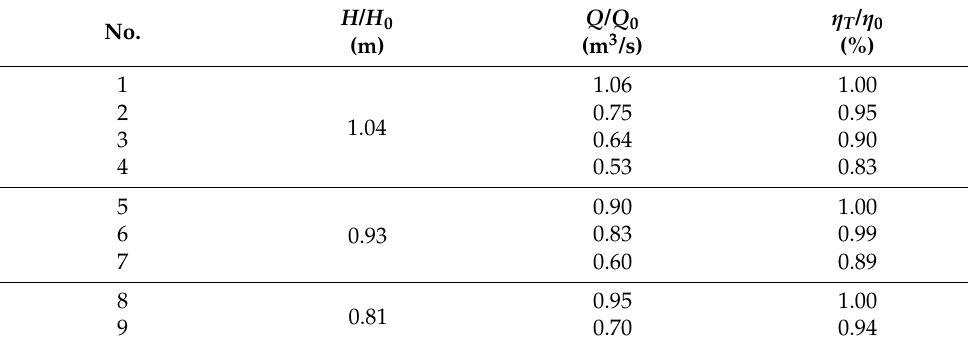
Table 1. The turbine operation parameters without aeration system used in numerical analysis.